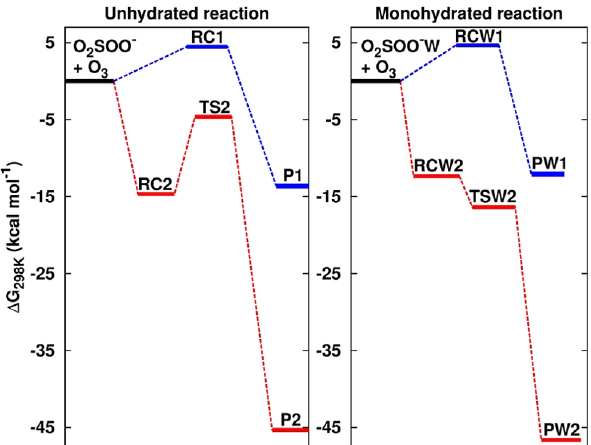
Figure 2. Formation Gibbs free energies of the most stable in- termediate species in the O 2 SOO − + O 3 reaction in the absence and in the presence of water. “W” is the shorthand notation for water. RC1, RC2, TS2, RCW1, RCW2, and TSW2 structures + 2O are shown in Fig. 1. P1 = O 2 + SO 2 + O − , P2 = SO − 2 , 3 3 + H = SO − ··· H + 2O PW1 = O 2 + SO 2 + O − 2 O, and PW2 2 O 2 . 3 3 Calculations were performed at the UCCSD(T)/aug-cc- pVTZ//UM06-2X/aug-cc-pVTZ level of